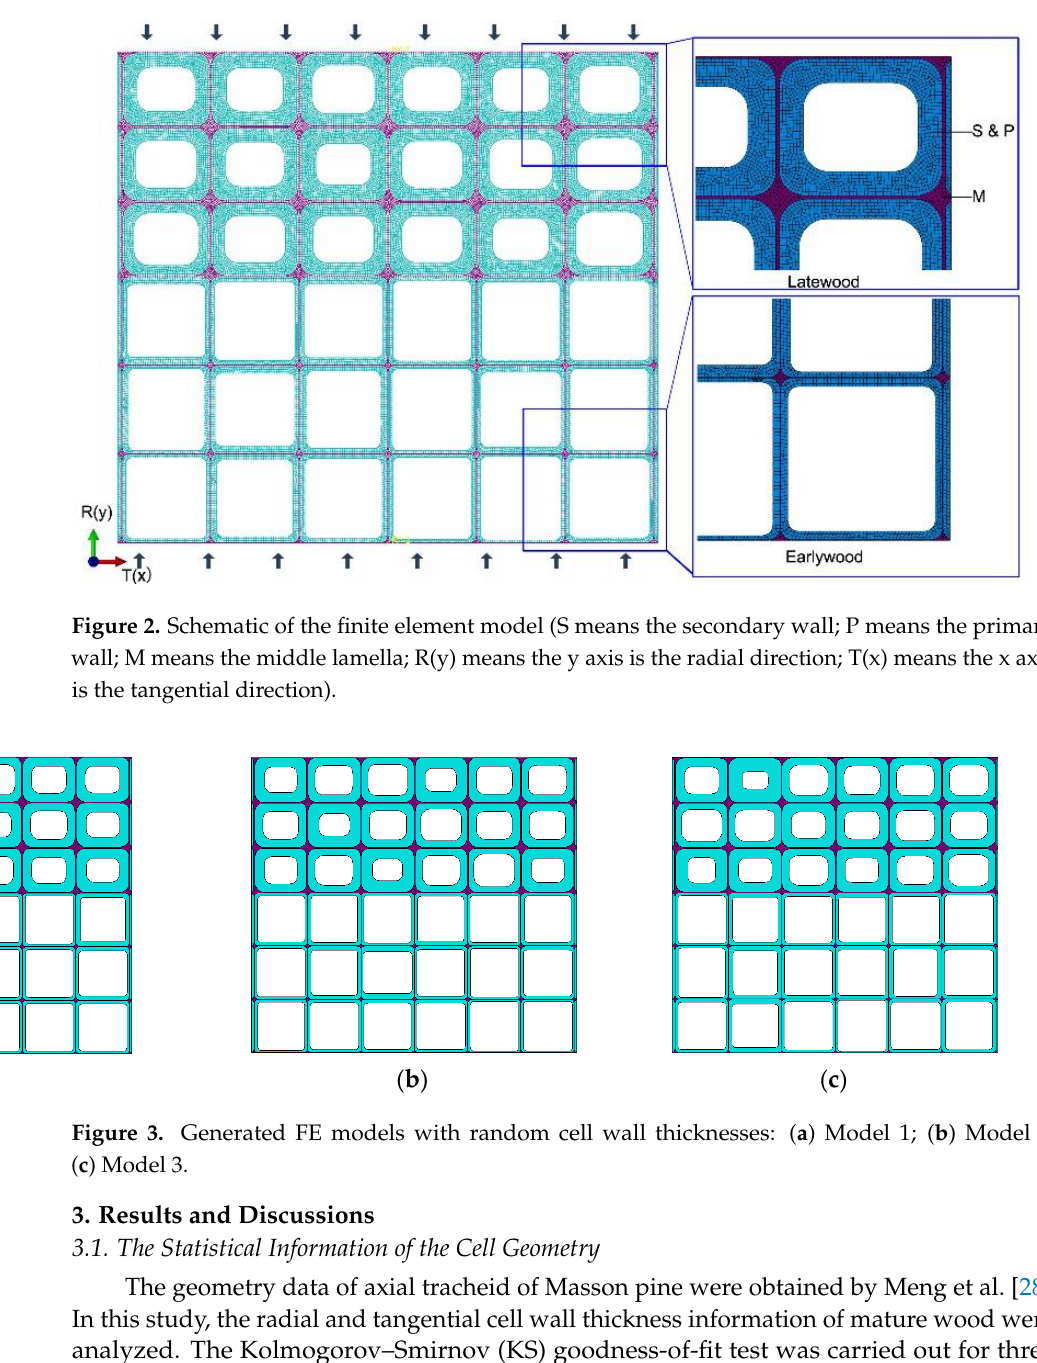
Table 1. Fitted parameters and KS test statistics (Unit: μm) .